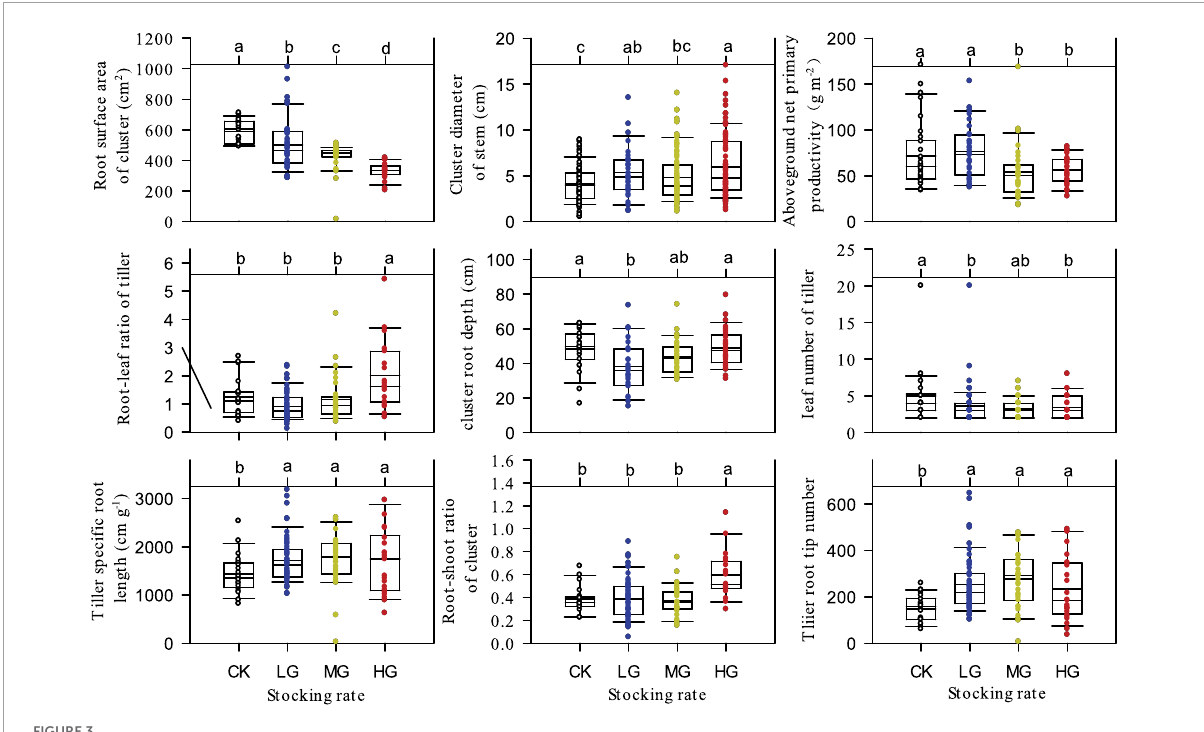
FIGURE3 Analysis of variance (ANOVA) for the functional traits of Stipa breviflora under different stocking rates.